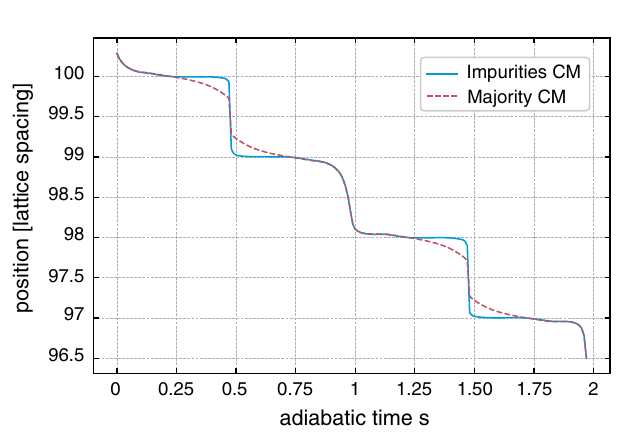
Fig. 5 | Nonlinearity-induced topological pumping in a Bose-Bose mixture. Center-of-mass (CM) trajectories of both species in a Bose-Bose mixture. Here, the interaction strengths are set as g ϕϕ ≃ 0.226 J 0 , g ϕσ ≃ − 11.32 J 0 and g σσ ≃ 2.26 J 0 . The majority atoms undergo the pumping sequence as in Fig. 3, while impurities feel a trivial sequence (Methods). Impurity atoms undergo quantized transport through interactions with their